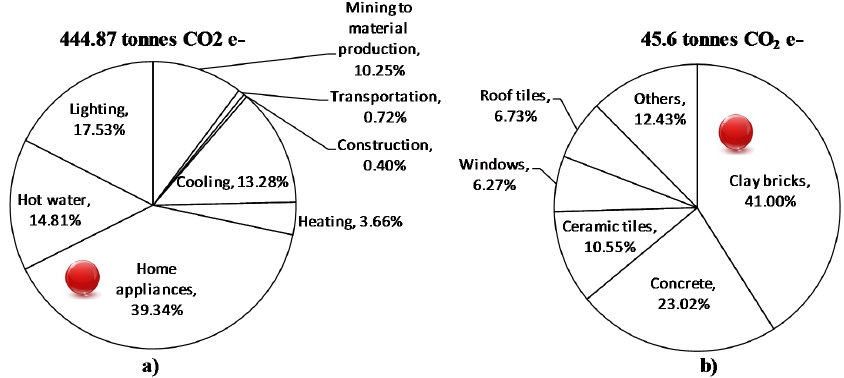
Figure 3. Breakdown of GHG emissions in terms of inputs ( a ) mining to use ( b ) mining to material production stage only.